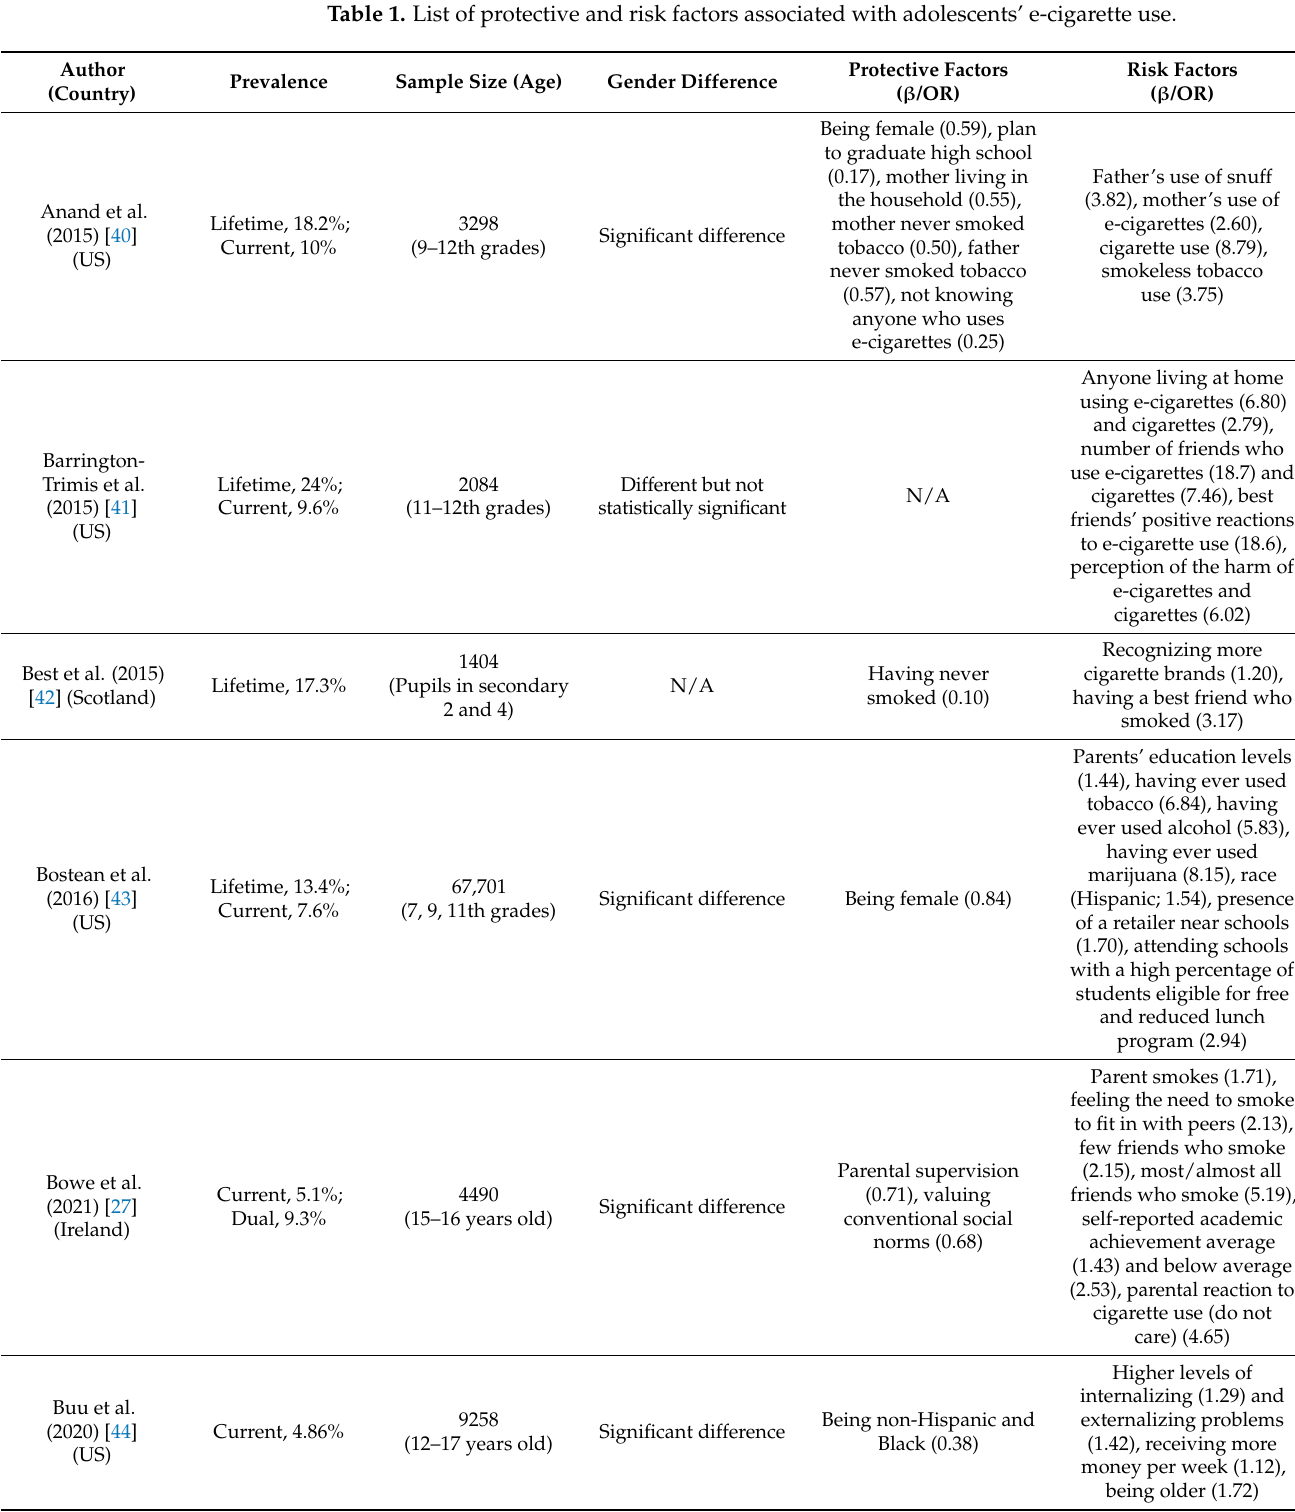
Table 1. List of protective and risk factors associated with adolescents’ e-cigarette